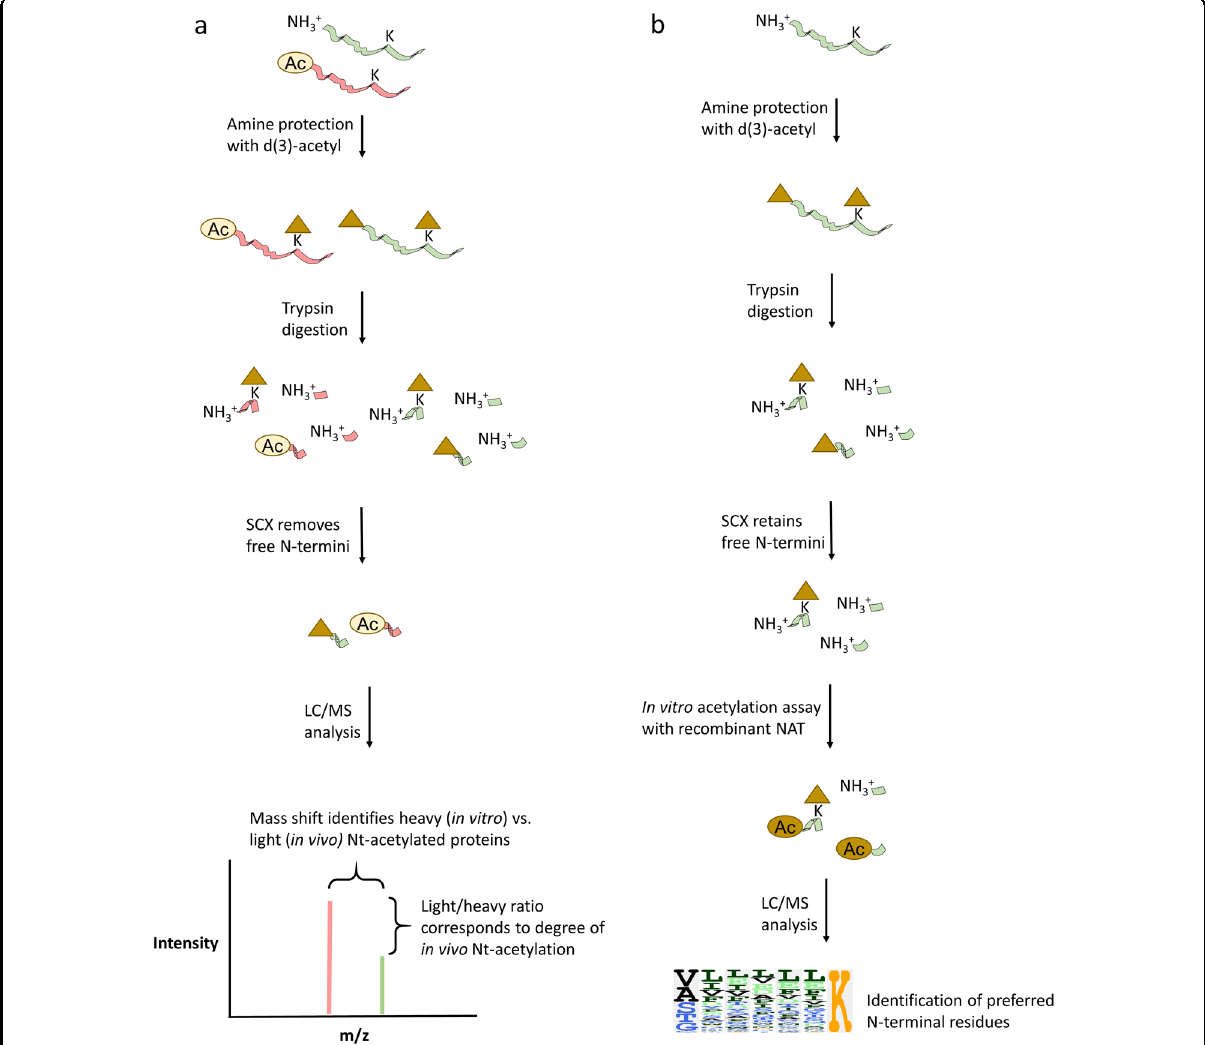
Fig. 6 MS-based approaches for the identi fi cation of NAT substrates and substrate speci fi cities. a The main steps of the work fl ow for SILProNAQ and COFRADIC. A protein mixture is trideutero-acetylated on free amine groups (N-termini or lysine residues (K)), digested with trypsin, and solid cation exchange (SCX) fractionated to remove free N-termini. In COFRADIC, a two-step fractionation scheme is performed at this stage (not shown). Peptides are then quanti fi ed by LC/MS, and the magnitude of intensity change in light/heavy Nt-acetyl groups (non-deuterated vs. trideuterated Nt-acetyl) measures the fraction of acetylation for a given N-terminus. b The generation of peptides for an in vitro peptide library is performed in the same manner as that of COFRADIC/SILProNAQ, except that at the SCX stage, peptides with free N-termini are retained rather than being discarded and are used as substrates for recombinant NAT enzymes. The output of this reaction is measured by LC/MS and is used to deduce the substrate preference of the NAT in